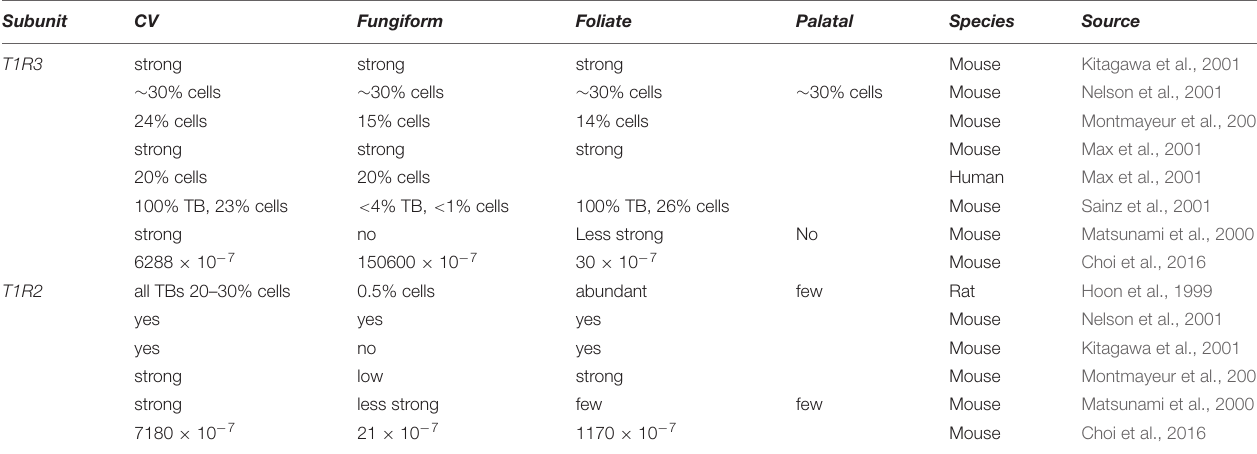
TABLE 1 | Expression of the sweet taste receptor subunits (T1R2/T1R3) in mammal taste papillae. Subunit CV Fungiform